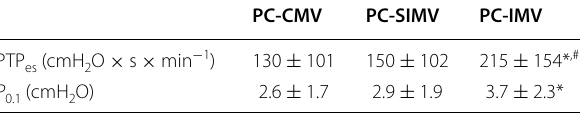
Table 3 Patient inspiratory effort [esophageal pressure– time product (PTP )] and respiratory drive [airway occlu- es sion pressure at 0.1 s ( P )] during three 0.1